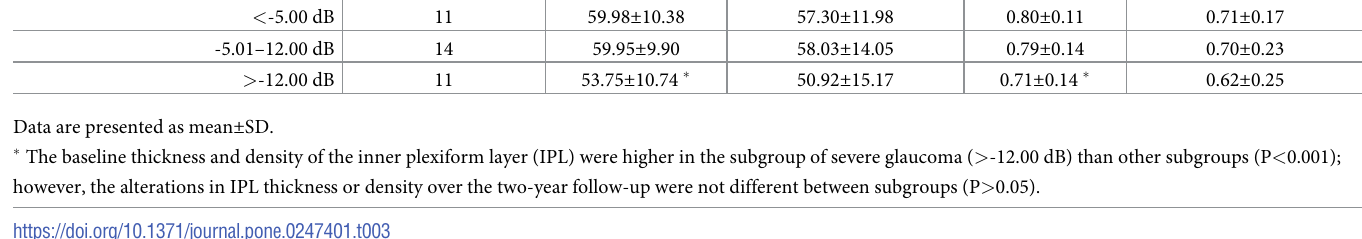
Table 3 presents the baseline and follow-up IPL data in the subgroups of glaucomatous eyes divided as mild, moderate, or severe based on 24–2 visual field scores at baseline. Although the baseline thickness and density of the IPL were significantly more advanced in eyes with severe glaucoma (P < 0.001), the progression of these parameters was not significantly different between subgroups (P = 0.98, and P = 0.87, respectively). Indeed, initial cross-sectional analysis of baseline parameters detected a significant correla- tion between RGCL and RNFL thicknesses (R = 0.92, P < 0.001), RGCL thickness and visual glaucomatous eyes. When analyzed cross-sectionally, the IPL thickness and density were also positively correlated (R = 0.75, P < 0.001). In addition, both the IPL thickness and the linear density ratio showed a significant relationship to the stage of glaucomatous injury. As pre- sented in Fig 2 , the IPL thickness was significantly correlated with the RNFL thickness (R = 0.32, P < 0.001), RGCL thickness (R = 0.35, P < 0.001), and the total deviation scores of